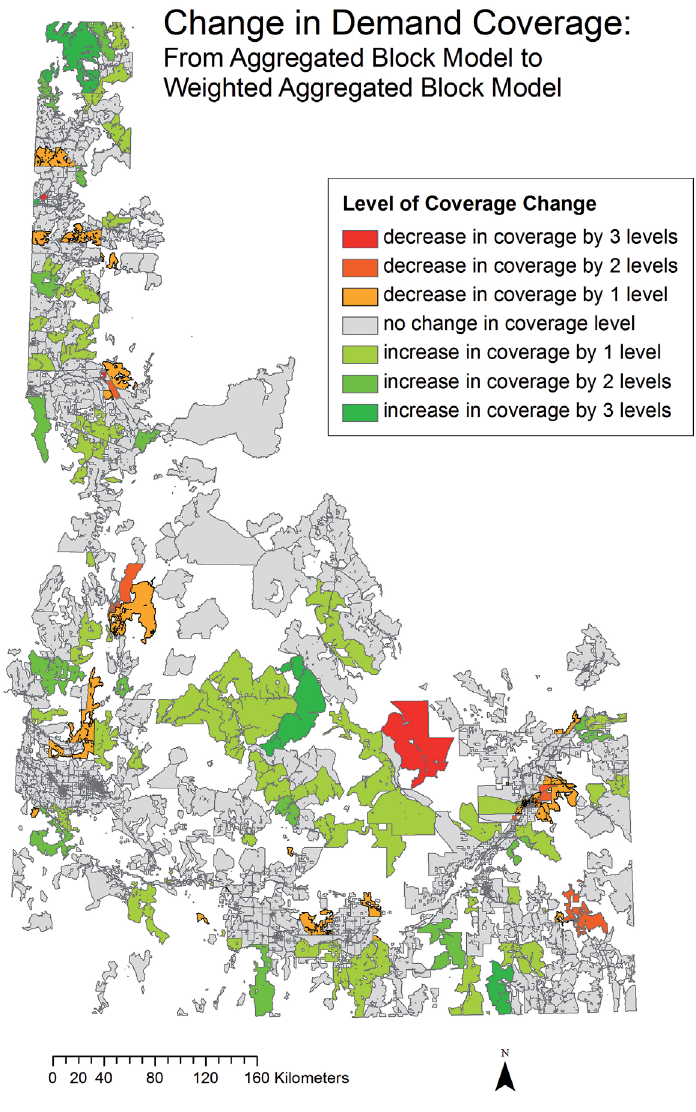
Fig. 8. Coverage change from non-weighted aggregated block model to weighted aggregated block